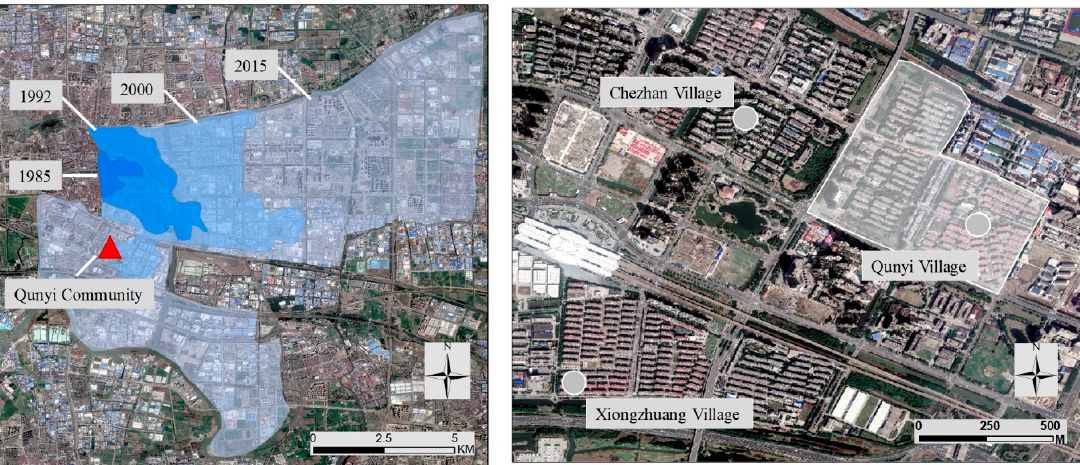
Figure 3. Spatial expansion of Kunshan economic and technological development zone (KETDZ) and the original location of Qunyi, Chezhan, and Xiongzhuang Villages.